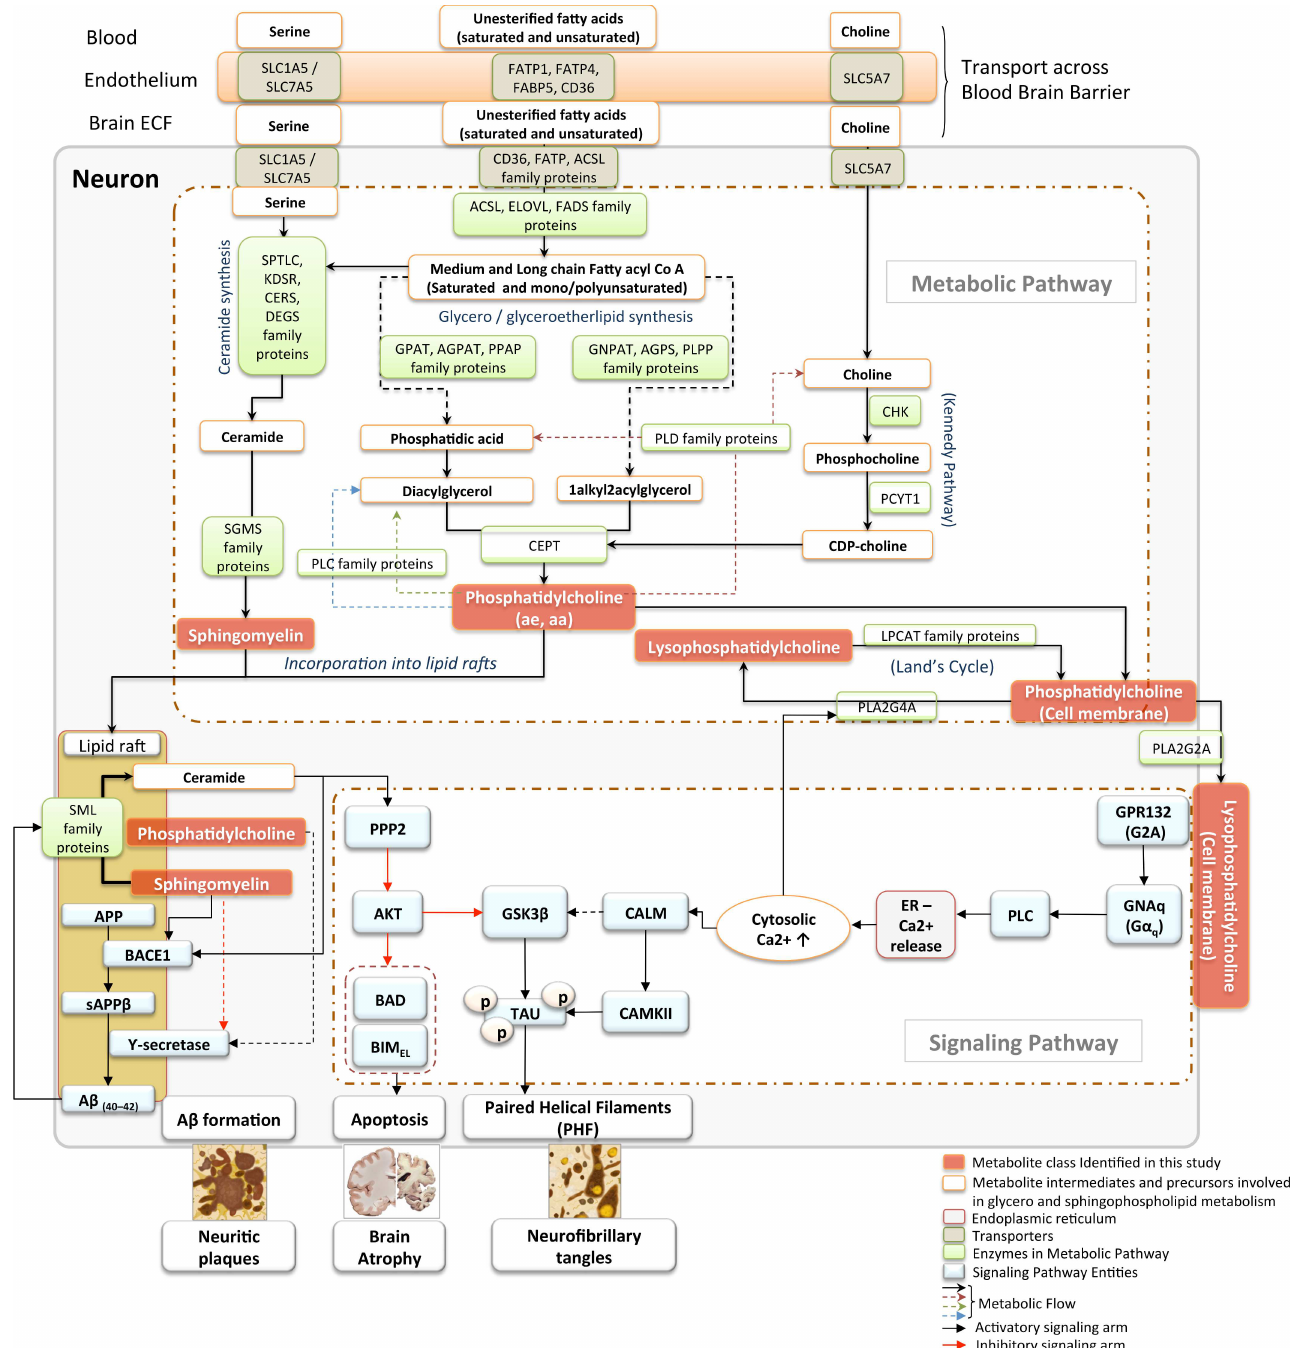
Fig 5. Metabolic pathways and signaling cascades involving glycerophospholipids and sphingolipids: relevance to AD pathogenesis. Schematic articulation of the core metabolic and signaling pathways in neurons, highlighting links between glycerophospholipid and sphingolipid classes of lipid species identified in the current study to be associated with the severity of AD pathology in the brain. Nutrient transporters (SLC5A7, SLC1A5, CD36, FATPs) present both at the BBB as well as the neuronal cell membrane mediate the uptake of amino acids, long chain fatty acids, and vitamin precursors into neurons necessary for the de novo synthesis of glycerophospholipid and SM lipid species [35,36].The “metabolic pathway” section of the diagram represents the core metabolic pathways involved in the synthesis and recycling of glycerophospholipid and sphingolipid species. The “signaling pathway” section connects these lipid species to the core representative signaling cascades implicated in mediating multiple aspects of AD pathology in the brain, such as formation of neuritic plaques, neurofibrillary tangles, and AD-like brain atrophy. In a condition-dependent manner, incoming free fatty acids are incorporated into glycerolipids or ceramides in the endoplasmic reticulum. Similarly, LCFAs are processed in peroxisomal organelles to generate ether lipids. Coupling with the Kennedy pathway, glycerolipids and